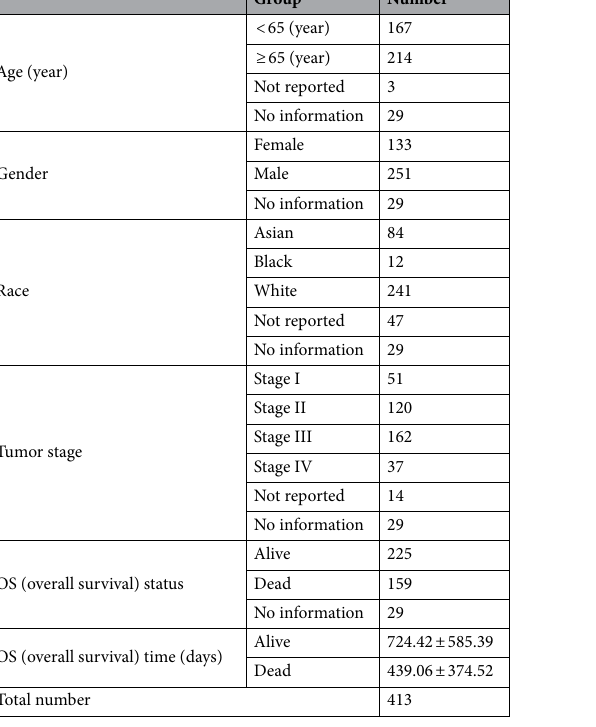
Table 1. Clinical characteristics of STAD